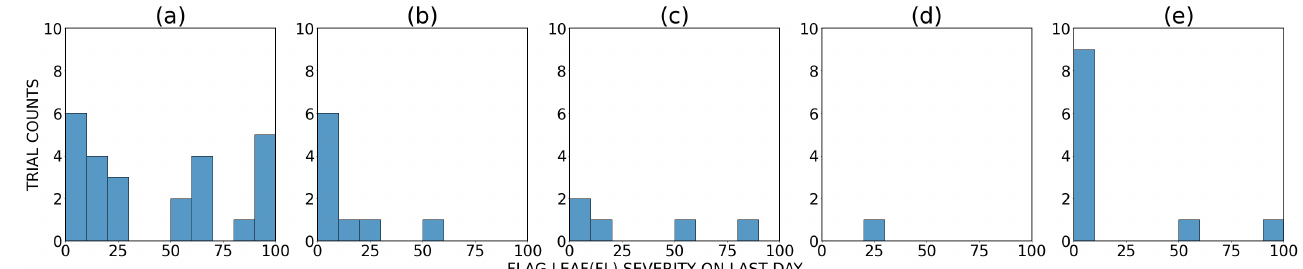
Figure 11. Flag leaf level yellow rust severity on the last day of disease observation. The horizontal axis represents the intensity of the severity and the vertical axis represents the count of trials in each category, where ( a ) Decreasing NDVI trend at disease, ( b ) Decreasing NDVI trend post disease observation disease, ( c ) High NDVI at late Growth Stage, ( d ) Increasing NDVI trend, ( e ) No major changes.